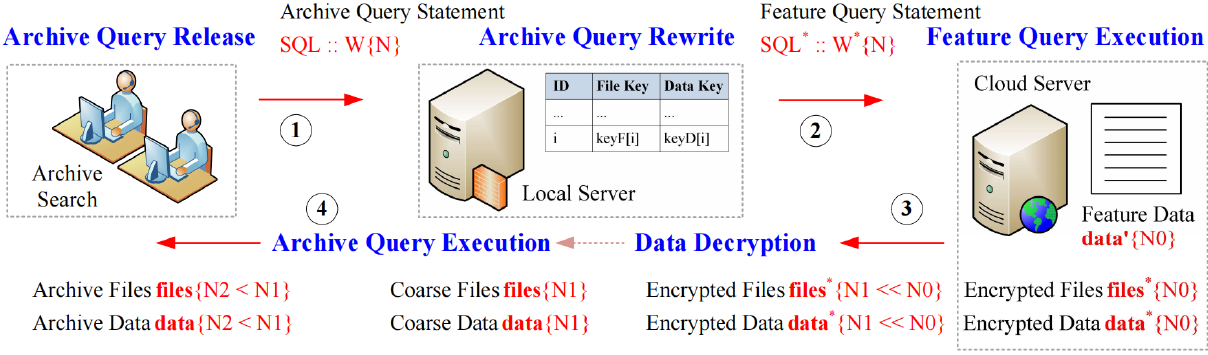
Figure 3. Implementation process of the confidentiality search model.